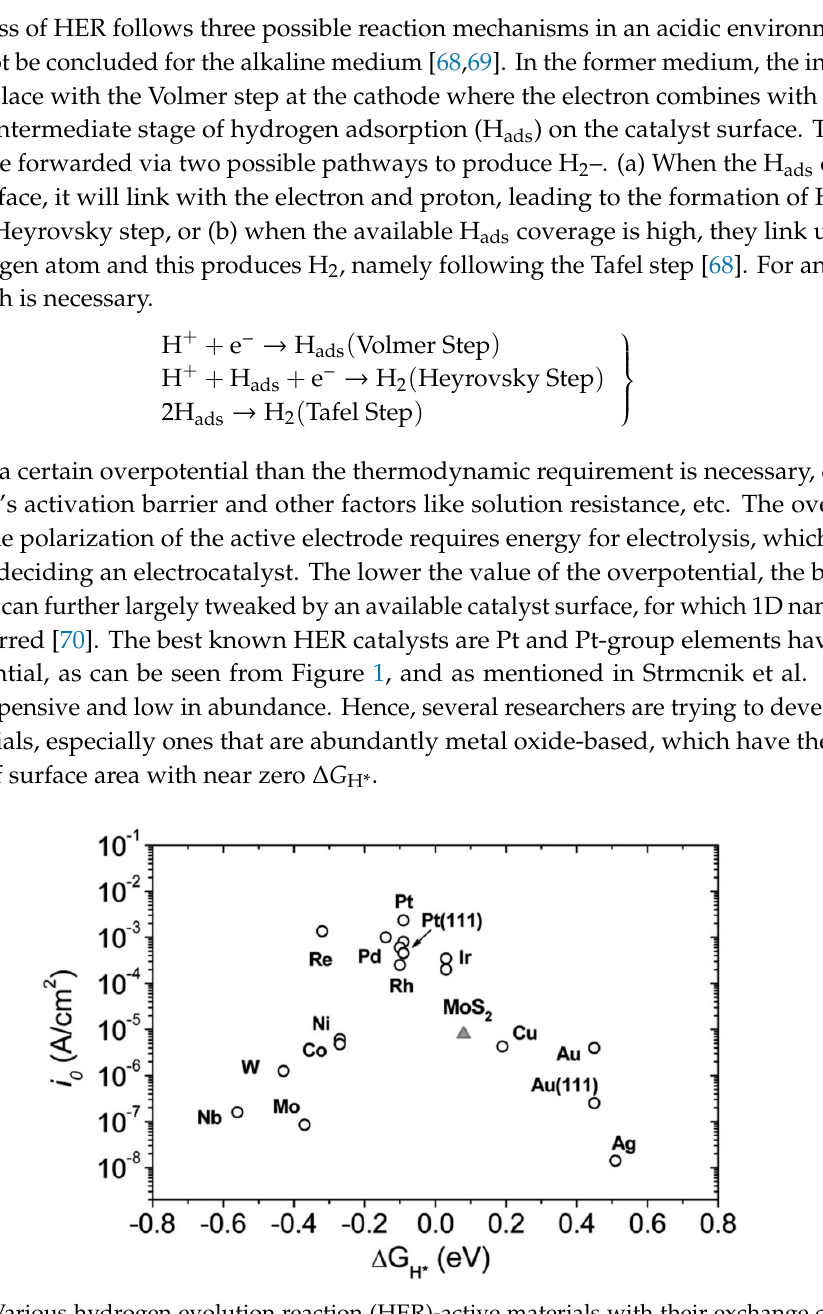
Figure 1. Various hydrogen evolution reaction (HER)-active materials with their exchange current density ( i 0 ) vs. hydrogen adsorption free energy ( ∆ G H* ). Platinum (Pt) and Pt-group materials shows the highest value for HER activity among various materials. Reproduced with permission from Ref. [69]. Copyright Science 2007.